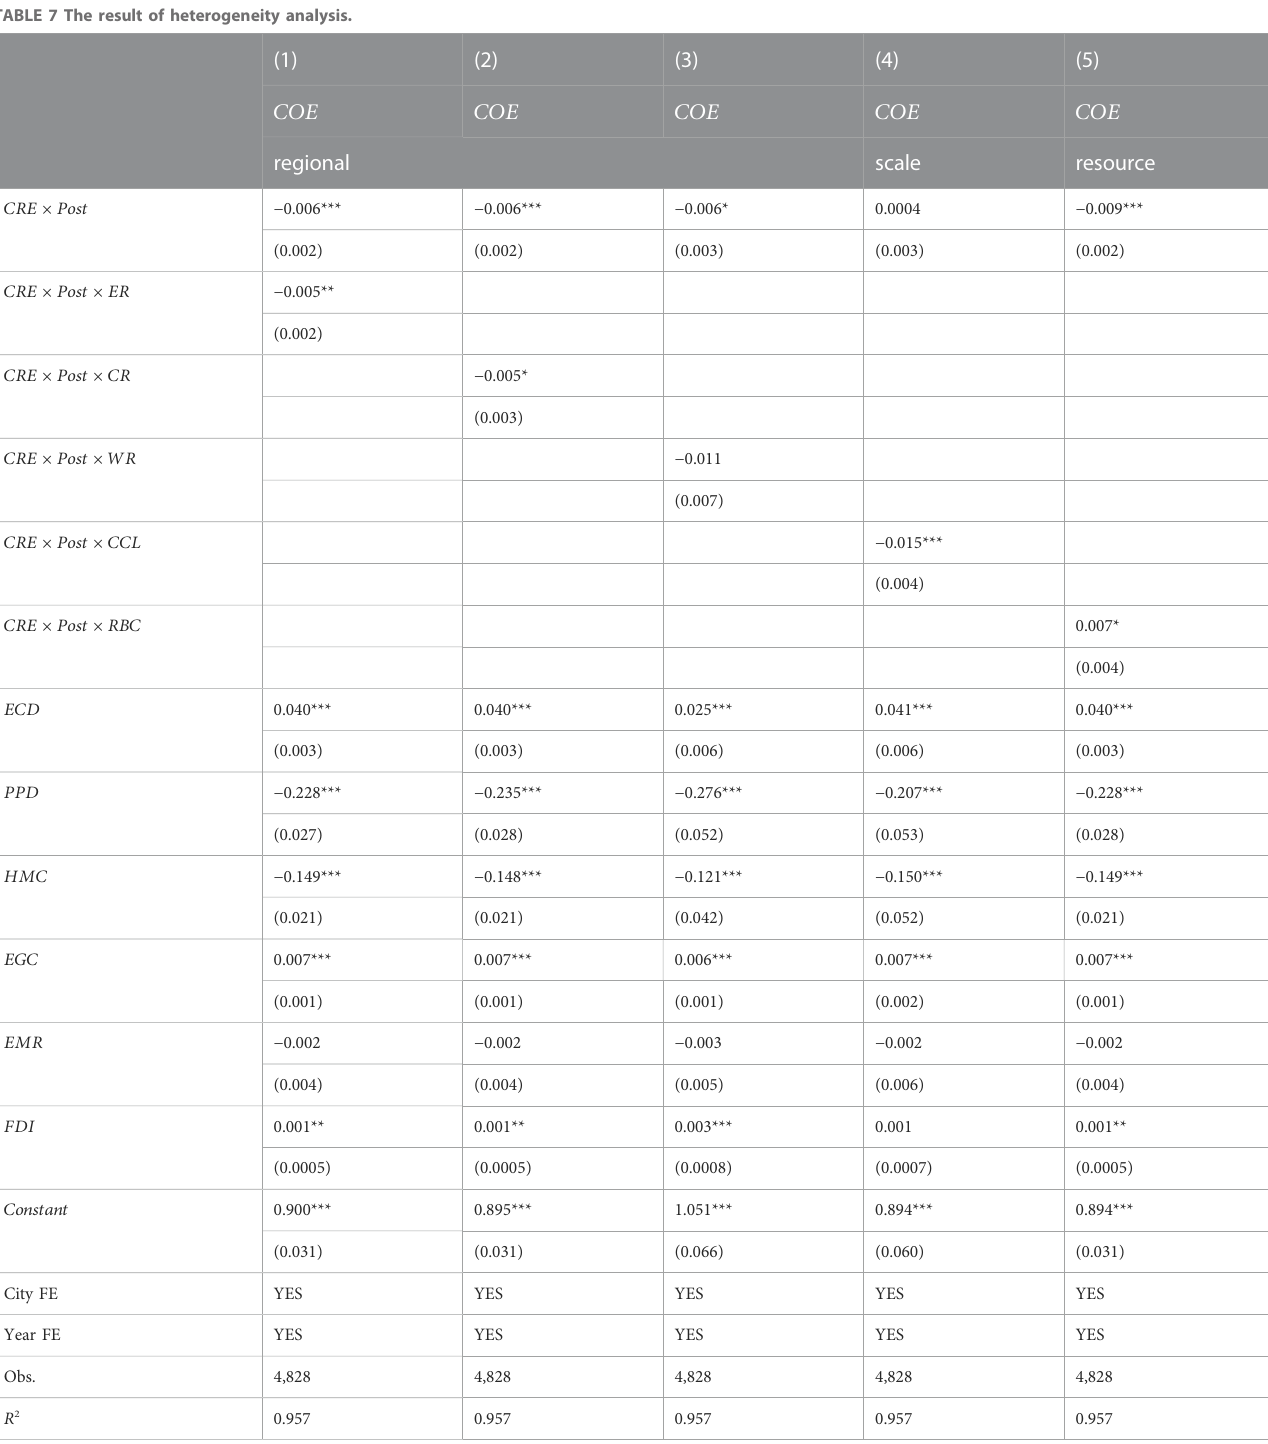
TABLE 7 The result of heterogeneity